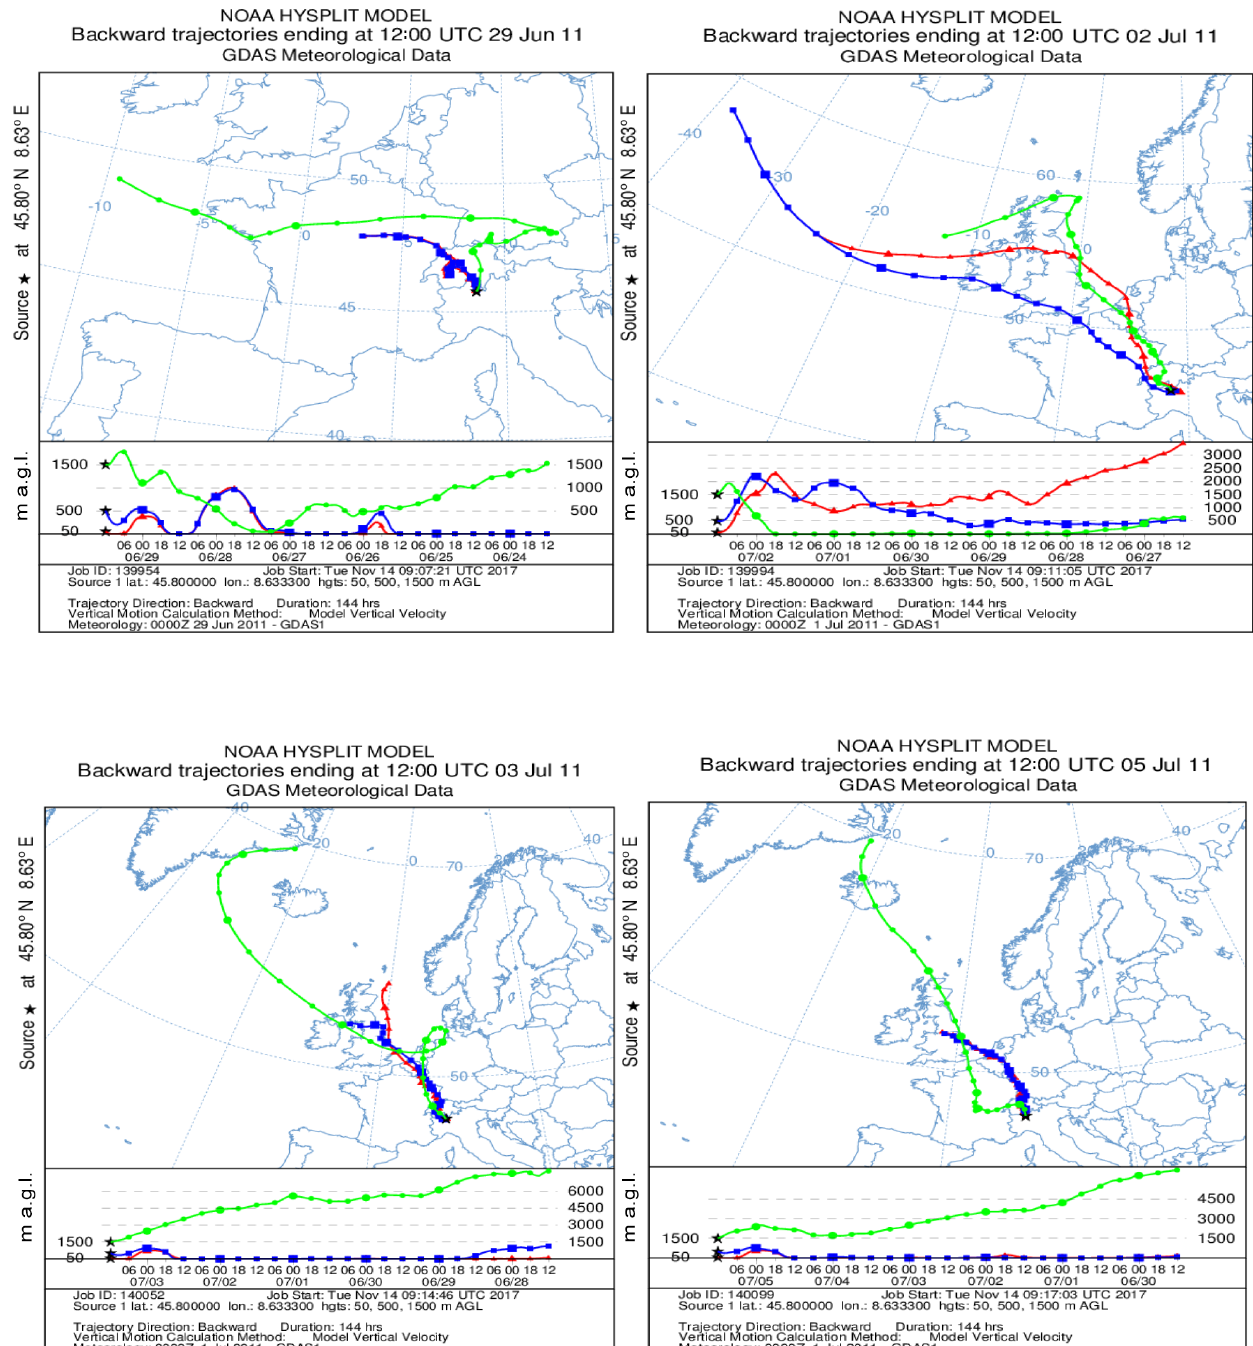
Figure 12. The 6d HYSPLIT back trajectories arriving at the JRC Ispra station during the episode of 28 June–4 July